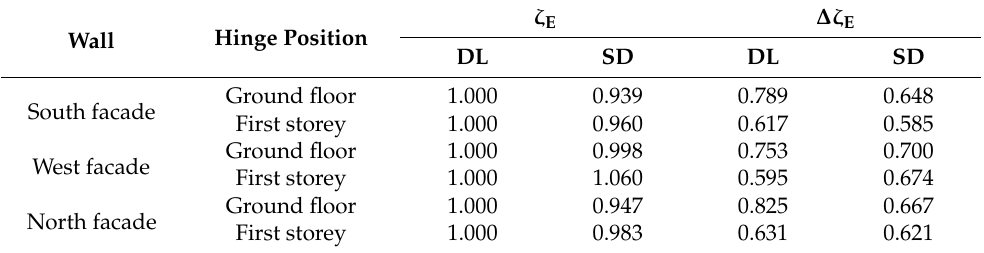
Table 7. Performance ratios ζ E at DL and SD limit states for single-unit model in as-built conditions according to kinematic